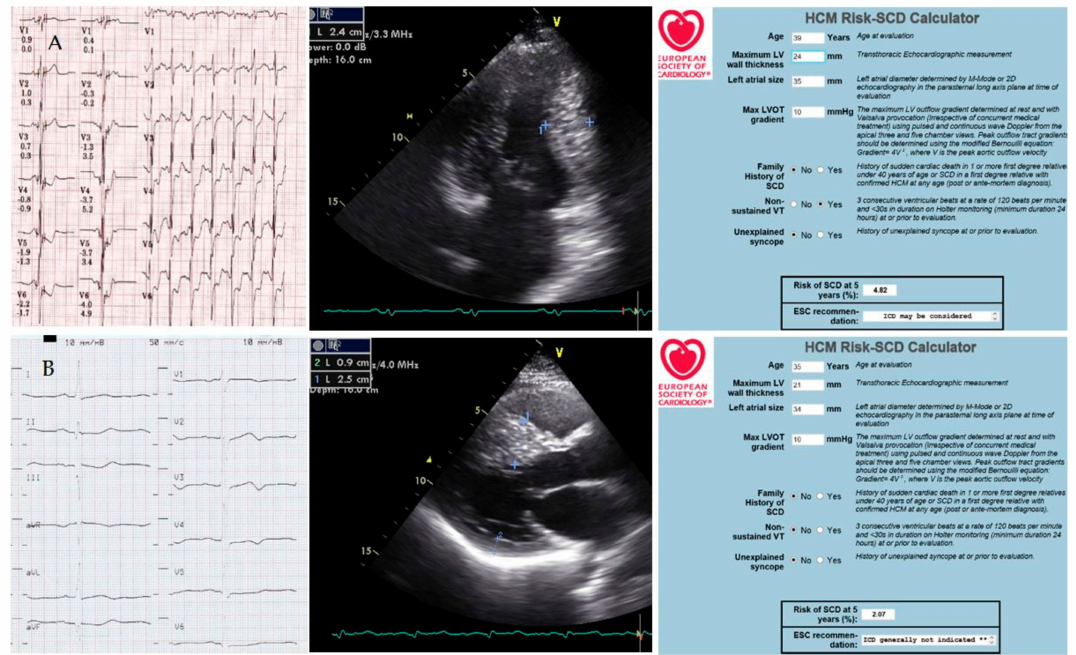
Figure 4. Results of Sanger sequencing and Pedigree. ( A )—Fragment of the capillary Sanger sequenc- ing (complementary strand). Heterozygous truncated variant c.3697G>A (chr11:47332189, p.Q1233*) in the exon 33 of the MyBPC3 gene found in proband and family members. The genetic variant is marked by an arrow. ( B )—Pedigree of the family with p.Q1233* mutation in the MyBPC3 gene. The proband is marked by an arrow. Closed symbols indicate family members with obstructive HCM; open symbols indicate healthy individuals.